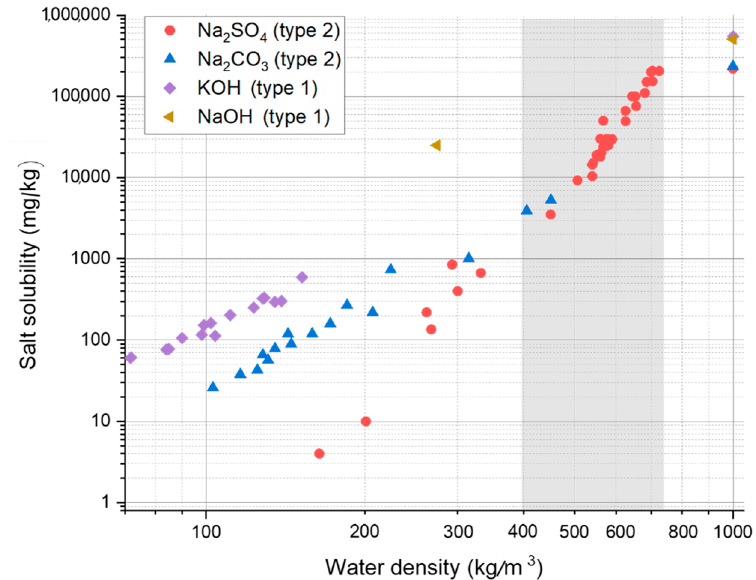
Figure 6. Solubility in the salt-depleted phase of various inorganic salts typically present in black liquor as a function of water density (based on [80]). The type of salt is indicated in parentheses. The grey shaded zone indicates the water density range typically encountered in HTL, e.g., 23 MPa/390 °C and 15 MPa/300 °C leading to water densities of 470 kg/m 3 and 725 kg/m 3 respectively.